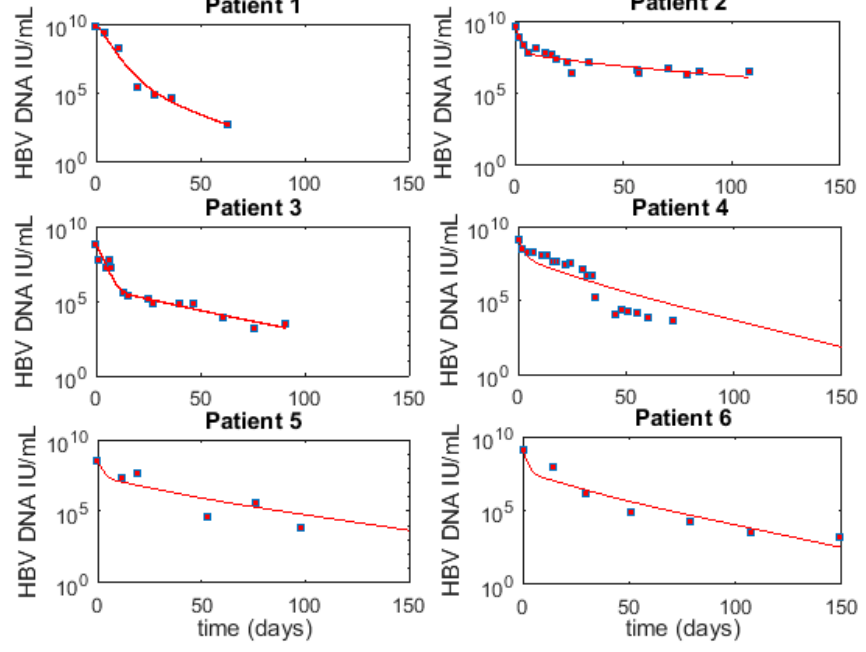
Figure 2. Best fit (line) to HBV viremia (squares) for six patients using M1 . The corresponding parameter values are given in Table 3. Table 3. Parameters for best fits for six patients using M1 . The parameters (cid:2012) , (cid:1868) (cid:3023) , (cid:1855) (cid:3023) , (cid:1870) , HT and AIC C represent the infected cell loss rate, the per infected cell production rate of HBV, the clearance rate of HBV, the proliferation rate, hepatocyte turnover and corrected Akaike information criterion, respectively.